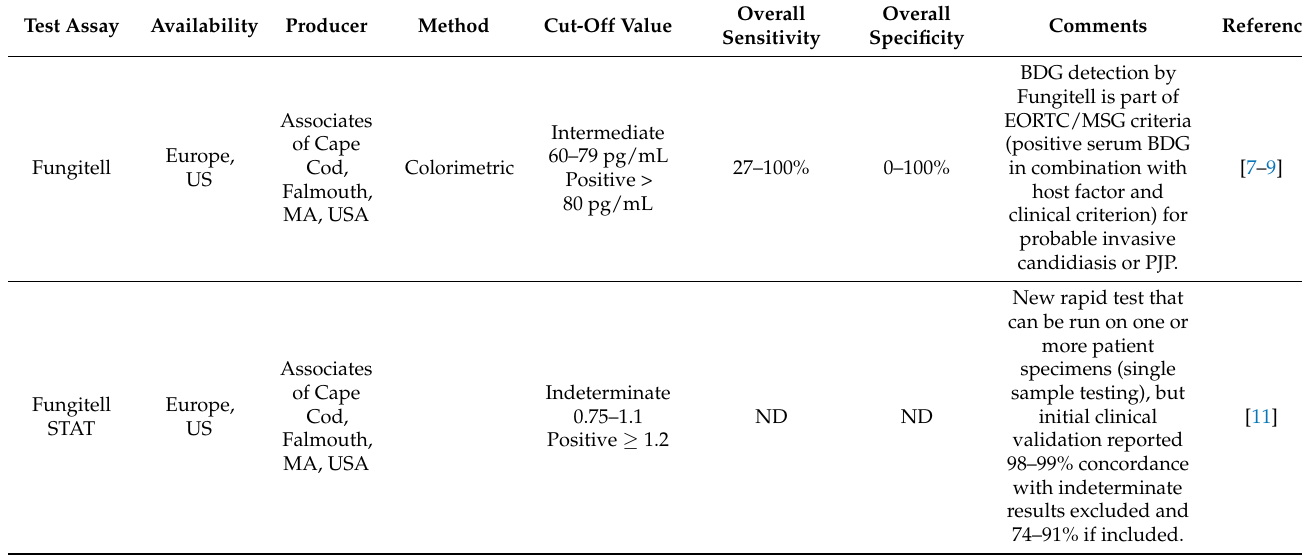
Table 1. Comparison of characteristics of different beta-D-glucan test